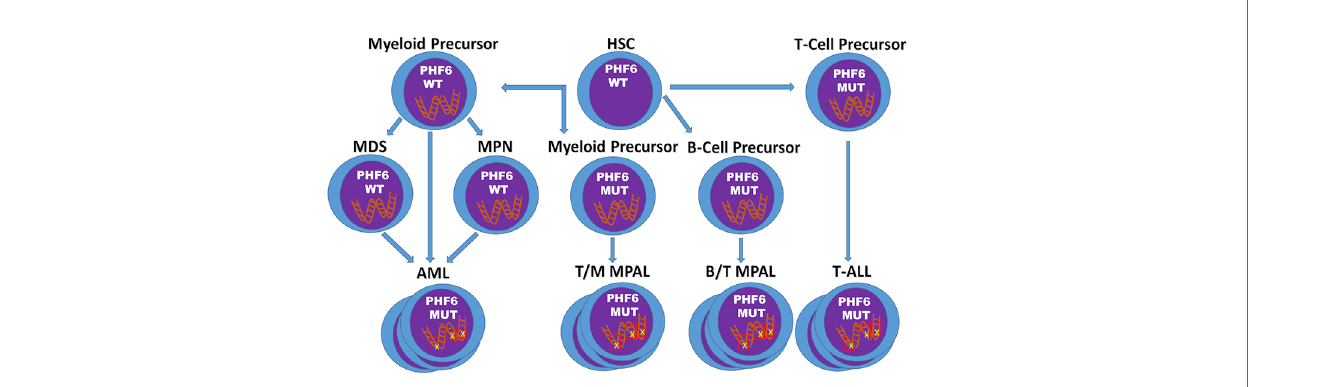
FIGURE 2 | Model of PHF6 in Hematopoietic Malignancies. The timing and context of the acquisition of PHF6 deletions/mutations appear to determine the fate of the resulting malignancy. In T-ALL, PHF6 deletions/mutations arise early, but are insuf fi cient for transformation into leukemia. In contrast, in myeloid neoplasms, PHF6 deletions/mutations tend to develop later possibly leading to disease progression. Finally, acquisition of inactivating mutations of PHF6 in myeloid or B-cell precursors may promote T-cell gene expression and eventual development of mixed phenotype